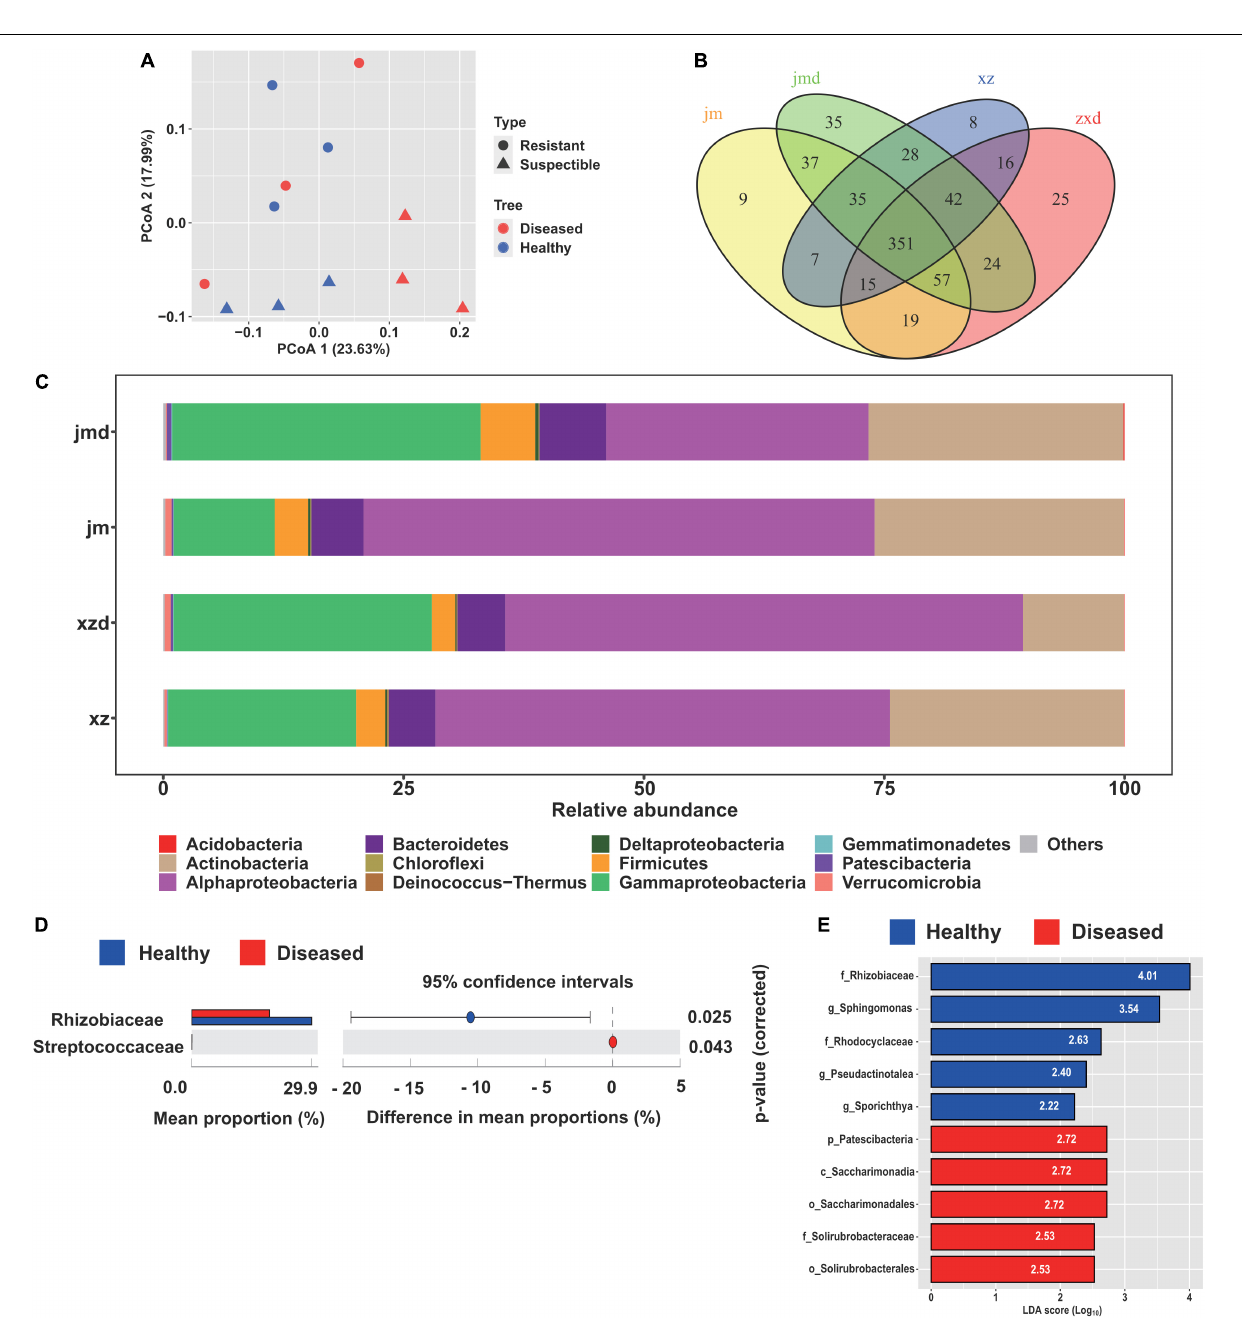
PDA plate, and the diameters of the inhibition zone